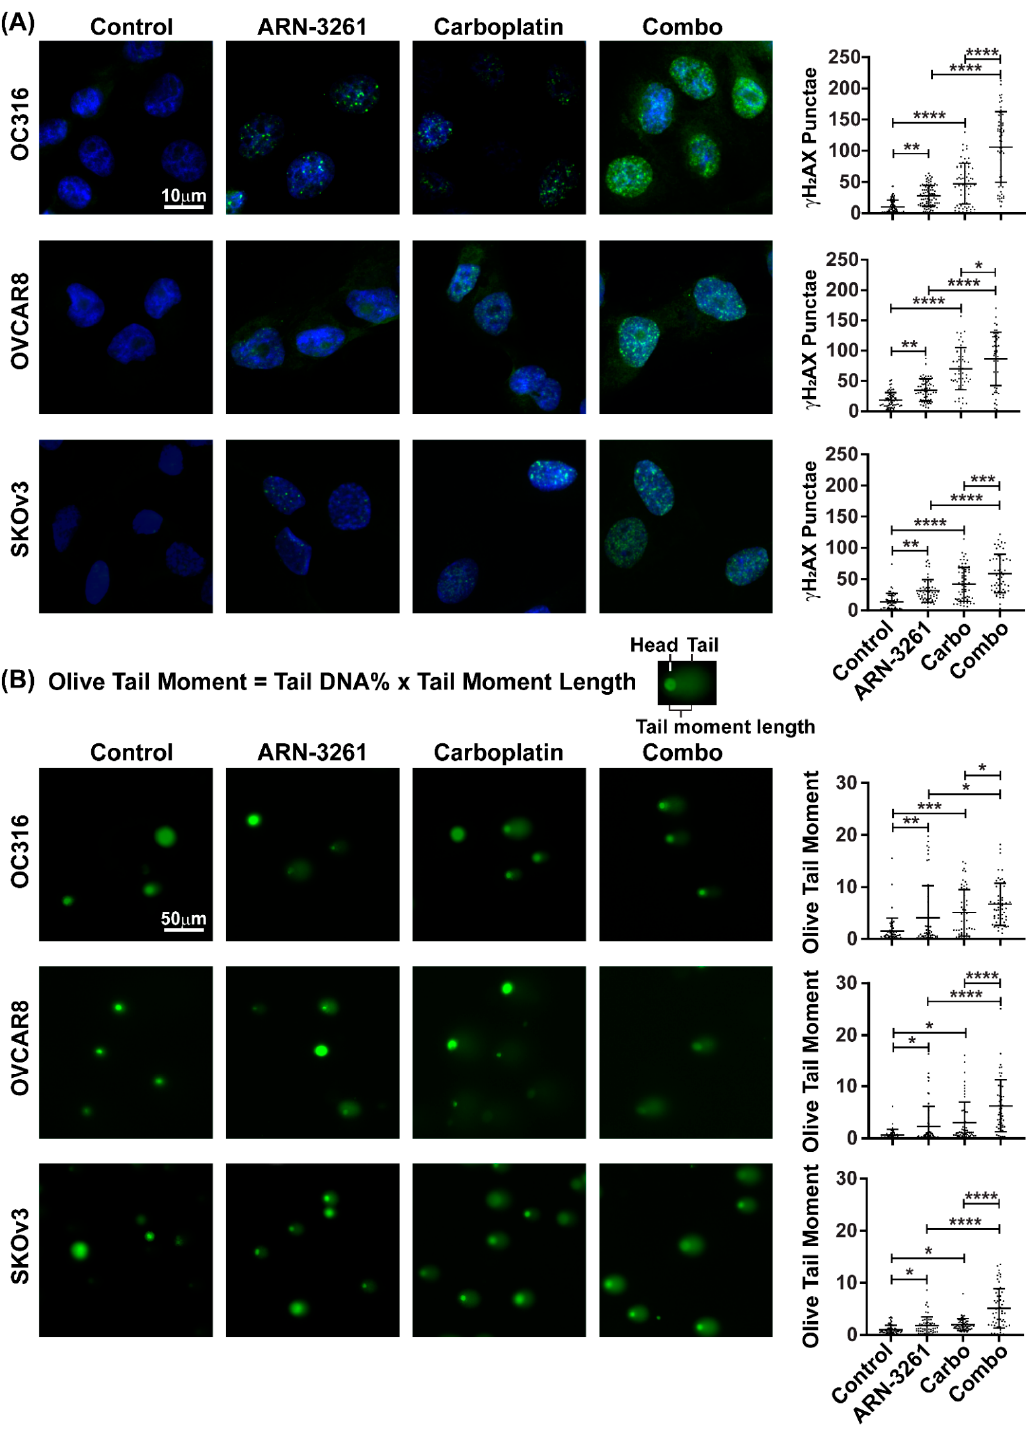
Figure 4. ARN-3261 enhances carboplatin-induced DNA damage. ( A ) OC316, OVCAR8 and SKOv3 ovarian cancer cells were treated with diluent, ARN-3261 (OC316 3 µ M, OVCAR8 3.0 µ M and SKOv3 3.5 µ M), carboplatin (OC316 15 µ M, OVCAR8 35 µ M and SKOv3 35 µ M) or the combination for 8 h and stained for γ -H2AX in green and for DNA with DAPI in blue. Each plot depicts the mean number of punctae (the bars indicate the standard deviation). ( B ) Cells were treated as described in ( A ) for 24 h. Then cells were dislodged, immobilized in agarose gel onto glass slide, and lysed. DNA was eletrophoresed in alkaline buffer and stained by Vista Green. Olive tail moment (OTL) was measured as described in the Methods. Each plot depicts the mean of OTL (the bars indicate the standard deviation). Statistical significance by one-way ANOVA is indicated by * p < 0.05, ** p < 0.01, *** p < 0.001 and **** p <